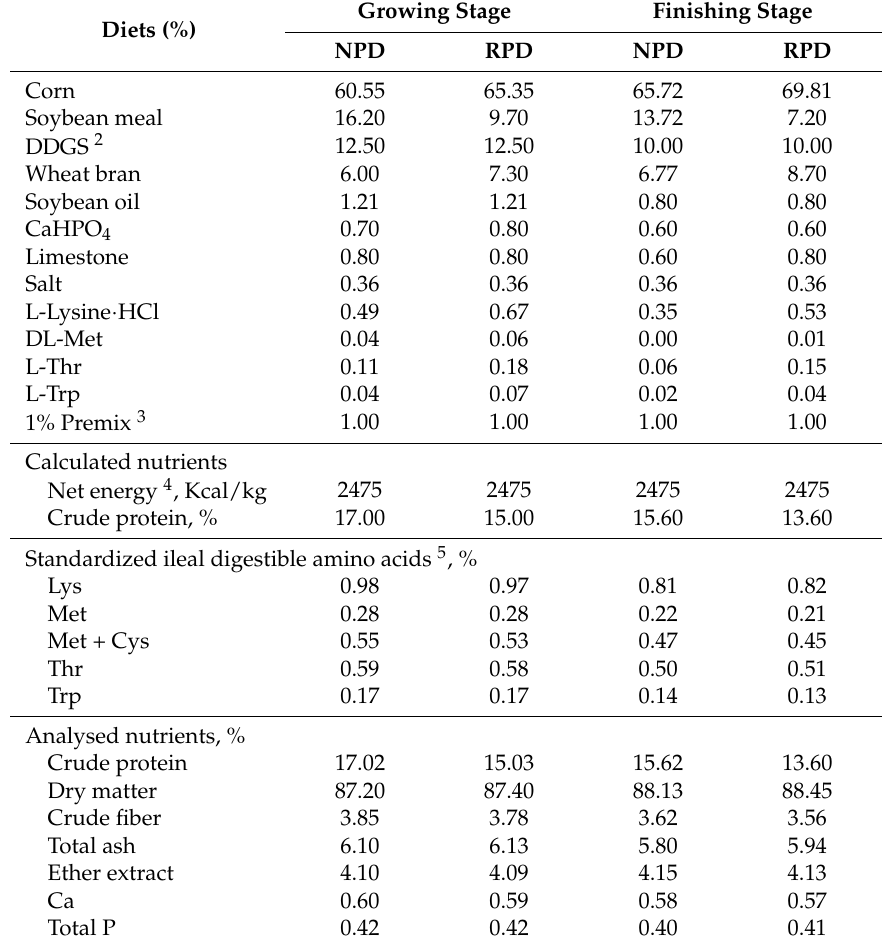
Table 1. The ingredient compositions and nutrient analysis of the experimental diets (%, as-fed basis) 1 . Diets